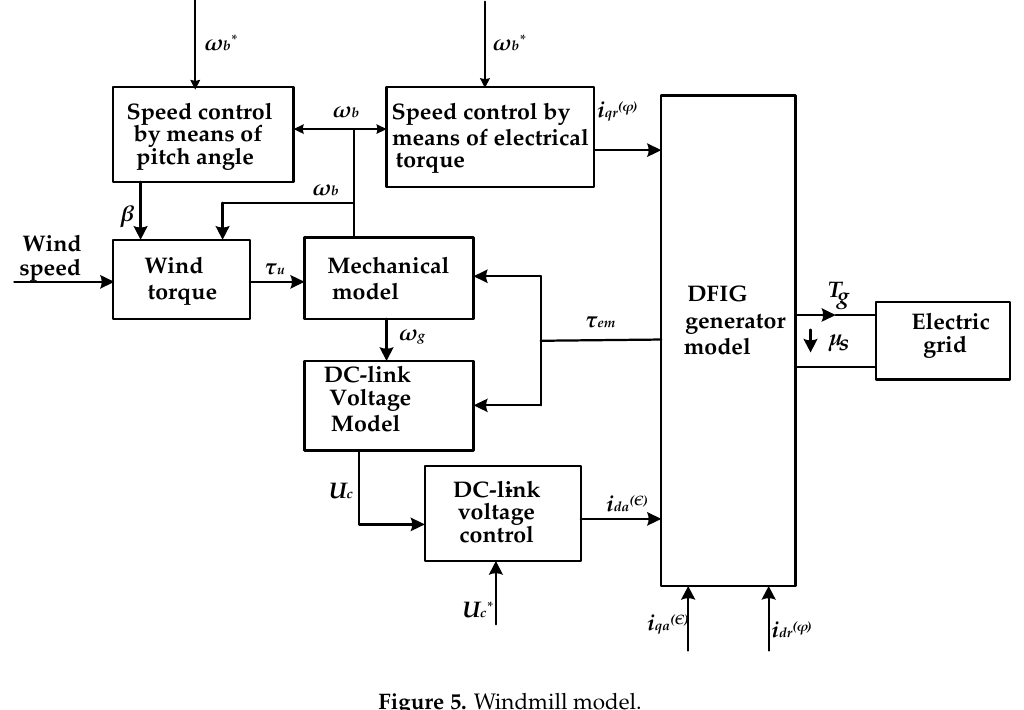
Figure 5. Windmill model. Figure 5. Windmill